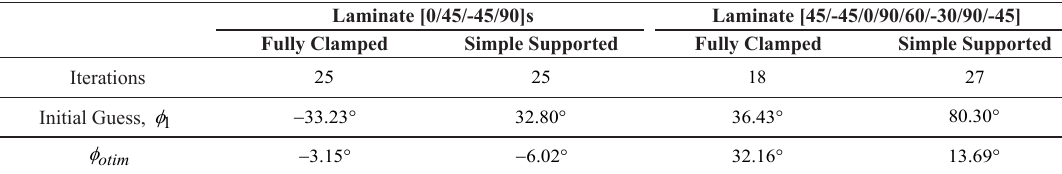
Table 4. Optimum φ .